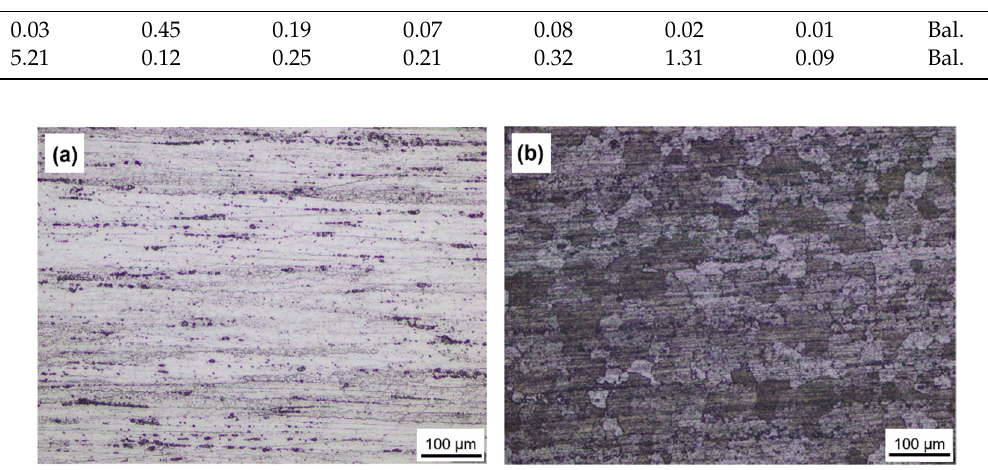
Figure 1. Microstructures of aluminium alloy rods: ( a ) AA7075 and ( b ) AA5083. Table 2. Mechanical properties of the base materials.